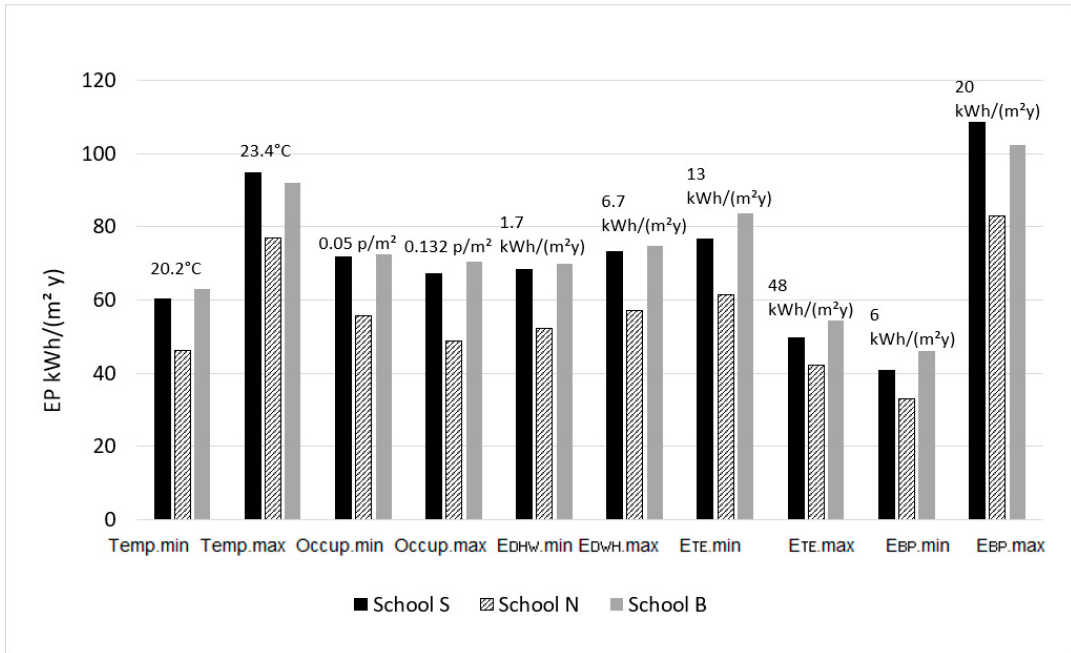
Figure 3. Calculated EP results in Schools S, N and B when each user-related parameter was set to its minimum and then to its maximum measured value, the other parameters being set to their average measured values. The user-related parameters were set according to their values in Table 2. E SH and E DHW are presented in terms of thermal energy. The area m² in the figure refers to A temp . The results show that the set points for indoor air temperatures and the E BP values generate the greatest variations in calculated EPs. The occupancy rates and E DHW values generate the least variations in calculated EPs. The E TE values also have a strong influence on the EPs. Similar variation effects were seen in all three schools.